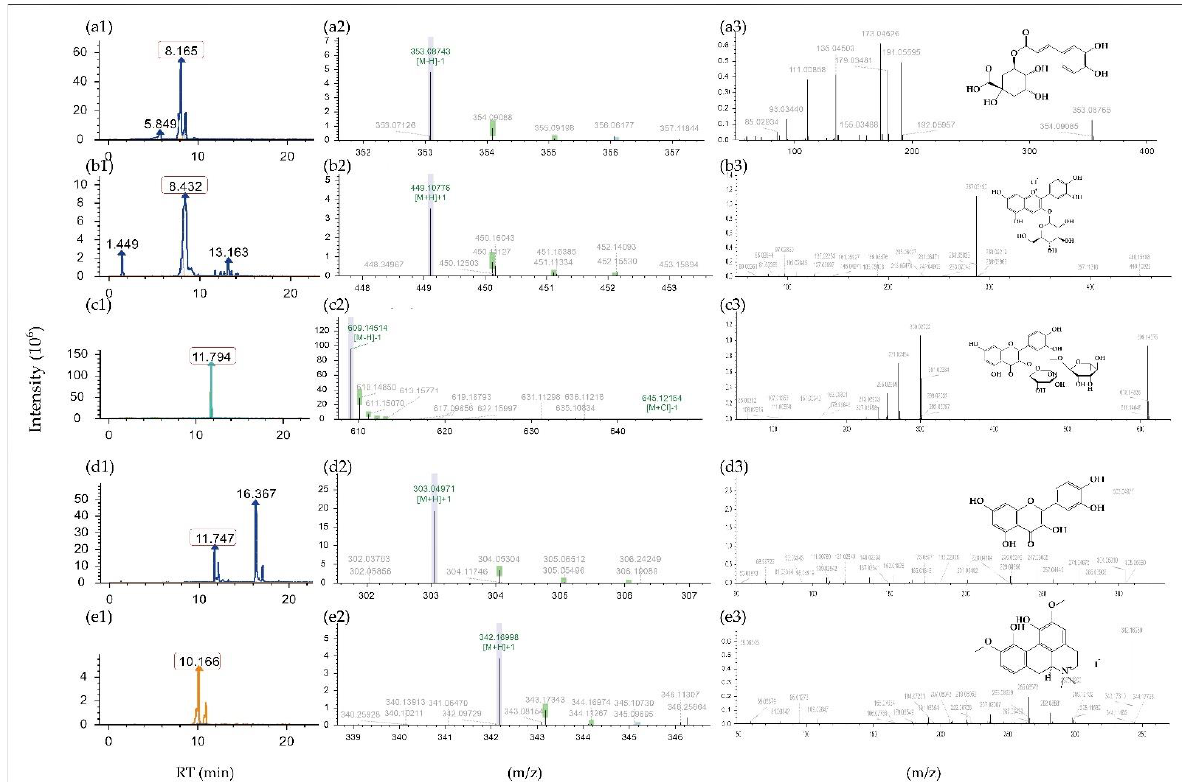
Figure 1. Retention time and mass spectrum of 5 examples: ( a1 – a3 ) Chlorogenic acid; ( b1 – b3 ) C3G; ( c1 – c3 ) Rutin; ( d1 – d3 ) Quercetin; ( e1 – e3 ) Magnoflorine.